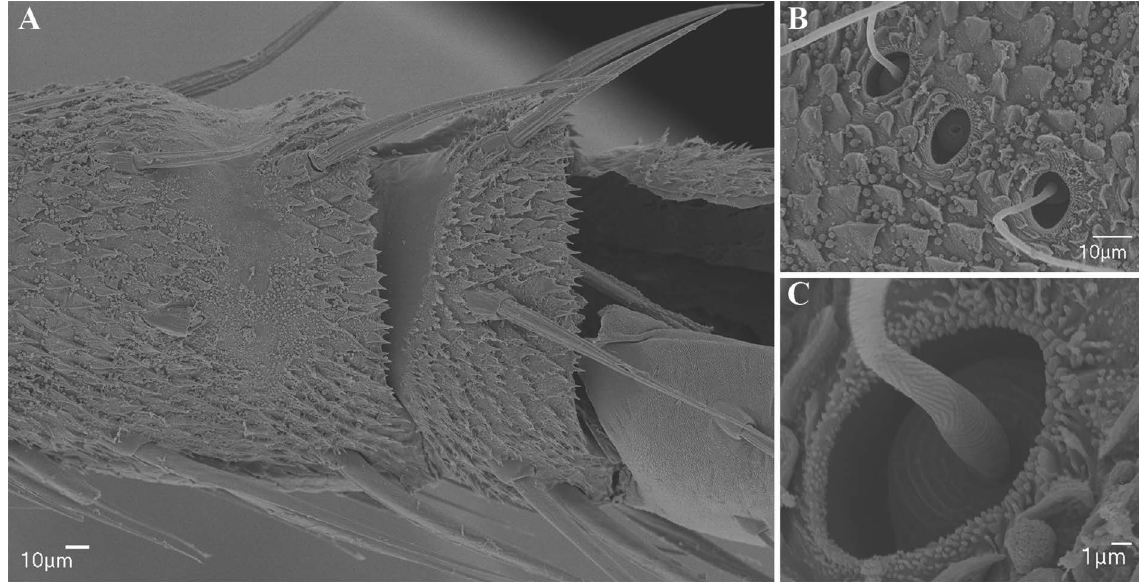
Fig. 88. Charinus africanus Hansen, 1921 (AMCC [LP 6943]), tarsus, ♀. A . Tarsus showing region of white ring. B . Trichobothria on distitarsus of leg IV. C . Trichobothrial